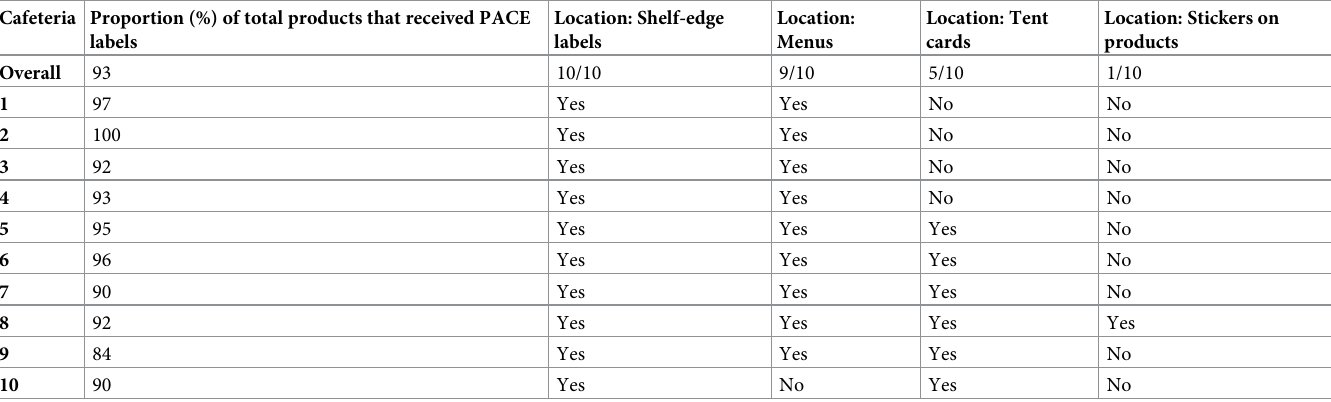
Table 2. Implementation of PACE labelling overall and by